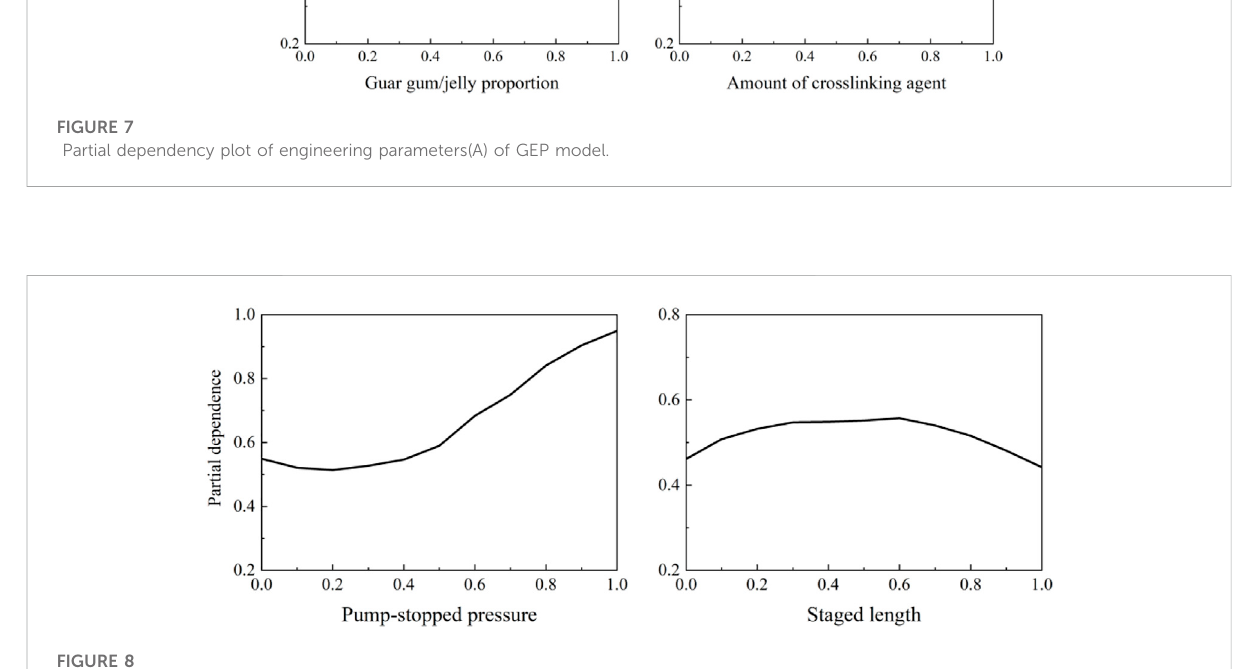
FIGURE 8 Partial dependency plot of engineering parameters(B) of GEP model.